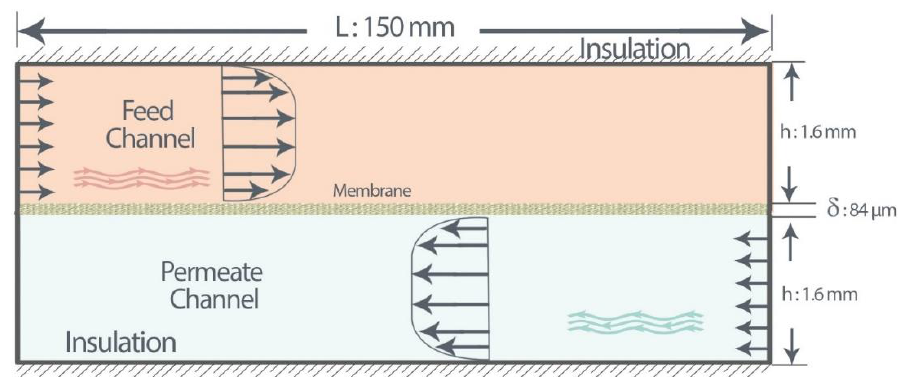
Figure 4. Schematic of flow configuration, counter-current operation, as a baseline for DCMD system. L, length of the channels; h, height of the feed and permeate channel; δ , membrane thickness.